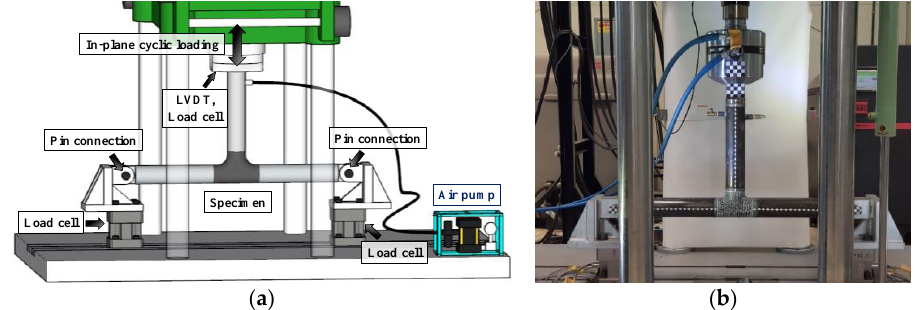
Figure 2. Test configuration: ( a ) Experimental setup; ( b ) Test specimen installed in the universal testing machine (UTM).